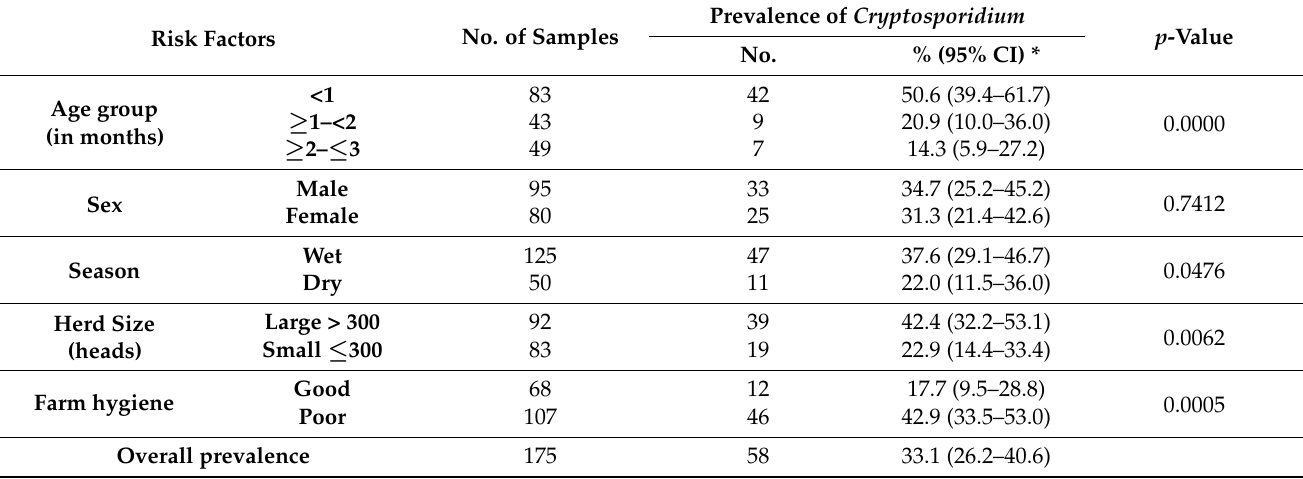
Table 1. Univariate analysis results of variables associated with Cryptosporidium -infected calves (No. 175) in Kuwait.